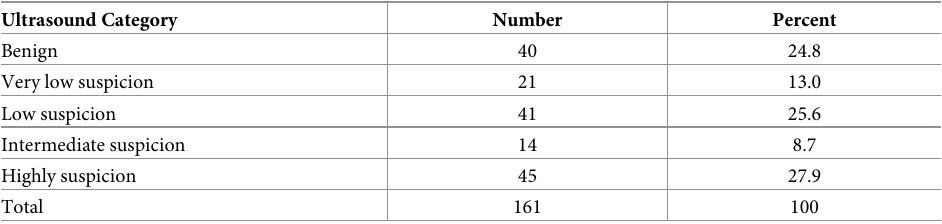
Table 1. Ultrasound categories of 161 thyroid nodules according to American thyroid association guidelines.